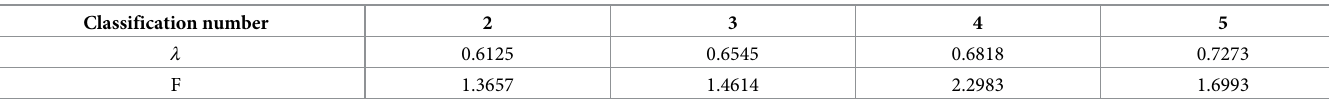
Table 6. F- Statistical scale.